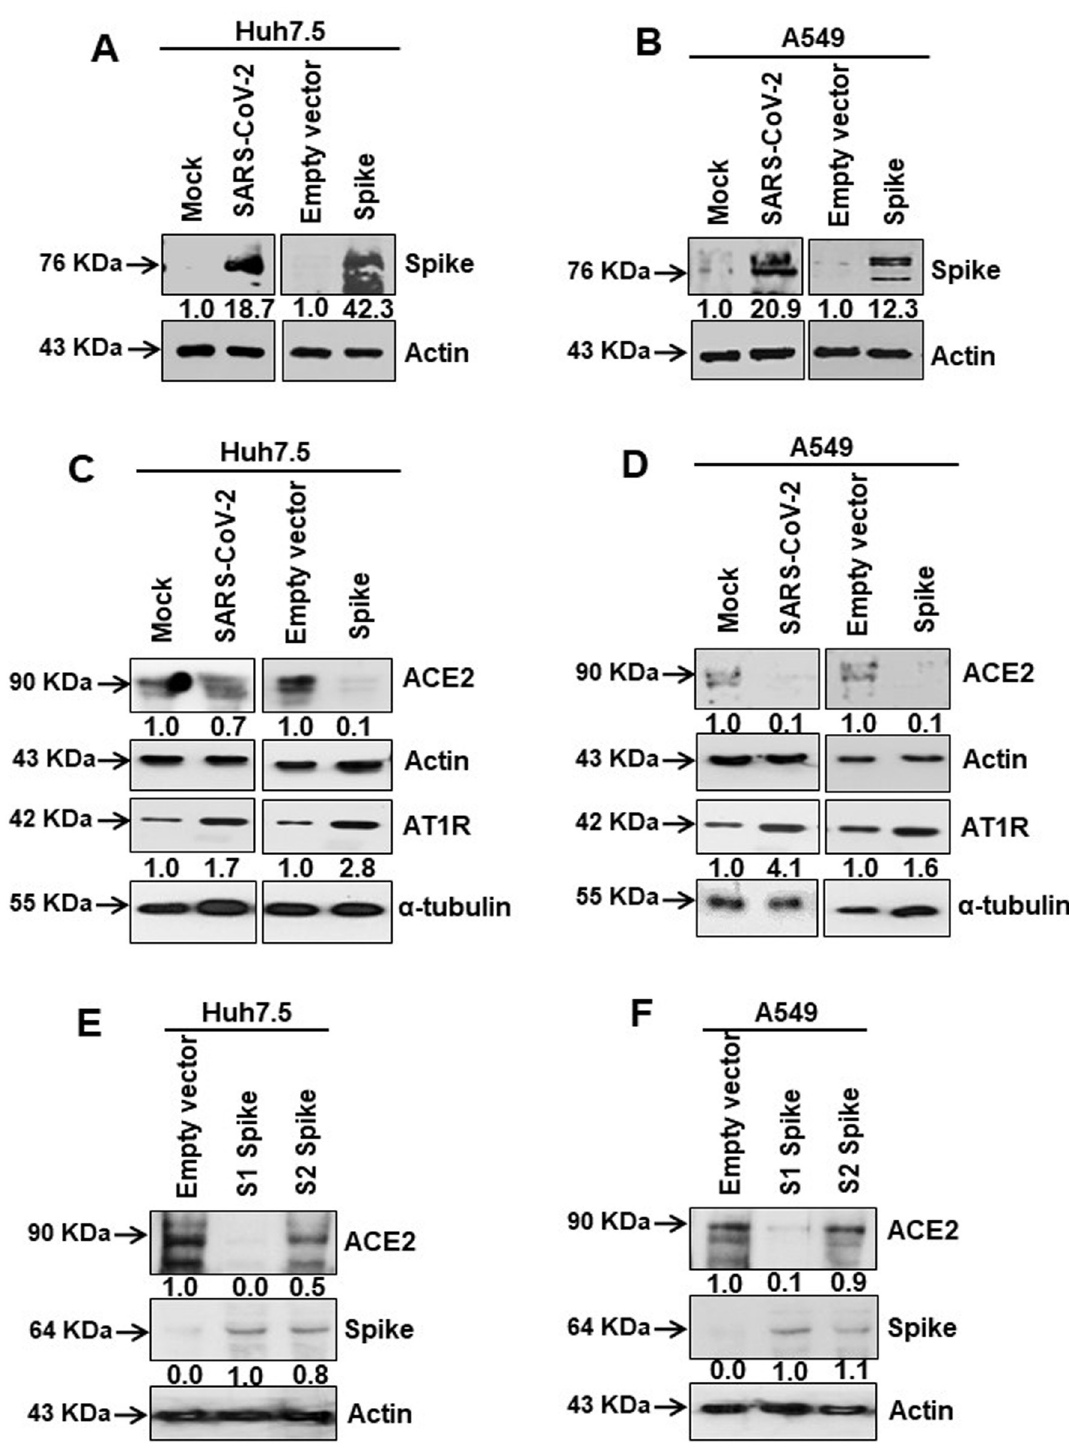
Fig 1. SARS-CoV-2 spike protein inhibits ACE2 expression. (A, B) Western blot analysis of SARS-CoV-2 spike protein expression in Huh7.5 and A549 cell lysates prepared after 48 h of mock- or SARS-CoV-2 virus infection, or transiently transfected with an empty vector or SARS-CoV-2 spike gene construct. (C, D) Western blot analysis of ACE2 and AT1 receptor expression in Huh7.5 and A549 cell lysates prepared after 48 h of mock- or SARS-CoV-2 virus infection, or transiently transfected with empty vector or SARS-CoV-2 spike gene construct. (E, F) Western blot analysis of ACE2 expression in Huh7.5 and A549 cell lysates prepared after 48 h of